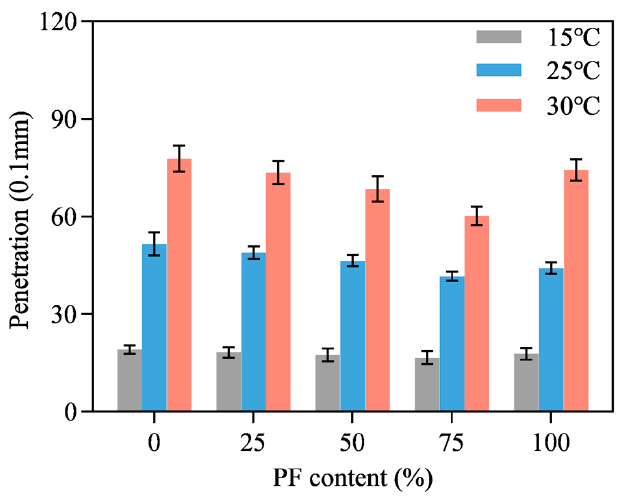
Figure 8. Filler-asphalt ratio of 1.0.